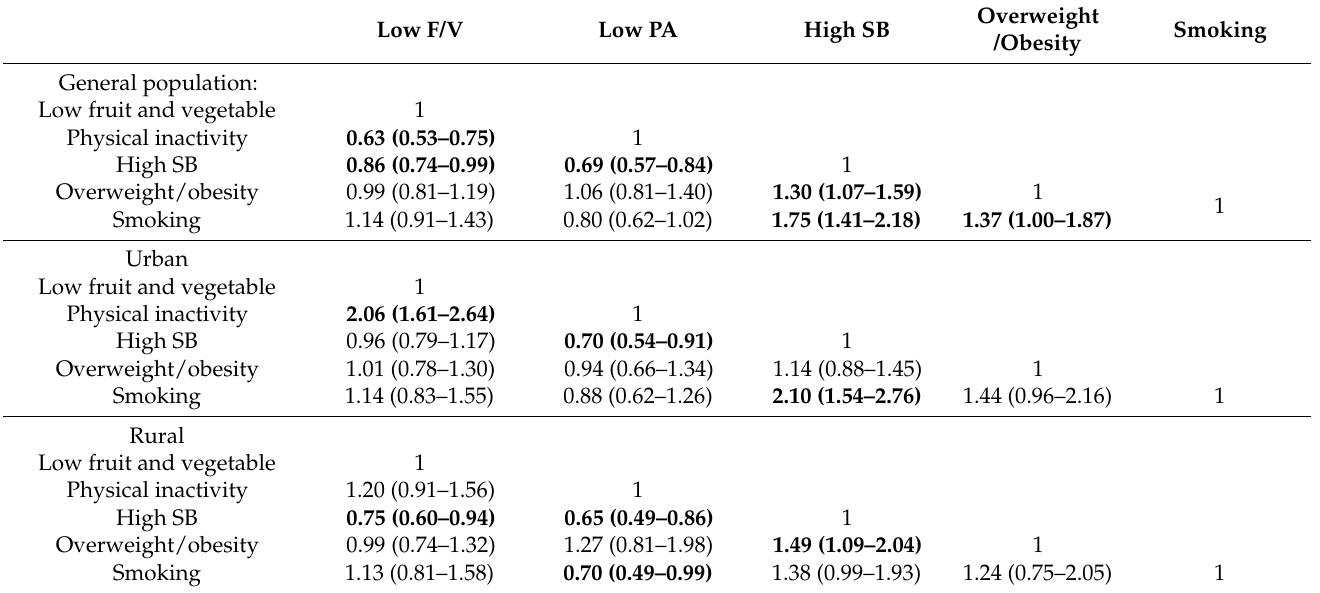
Overweight /Obesity